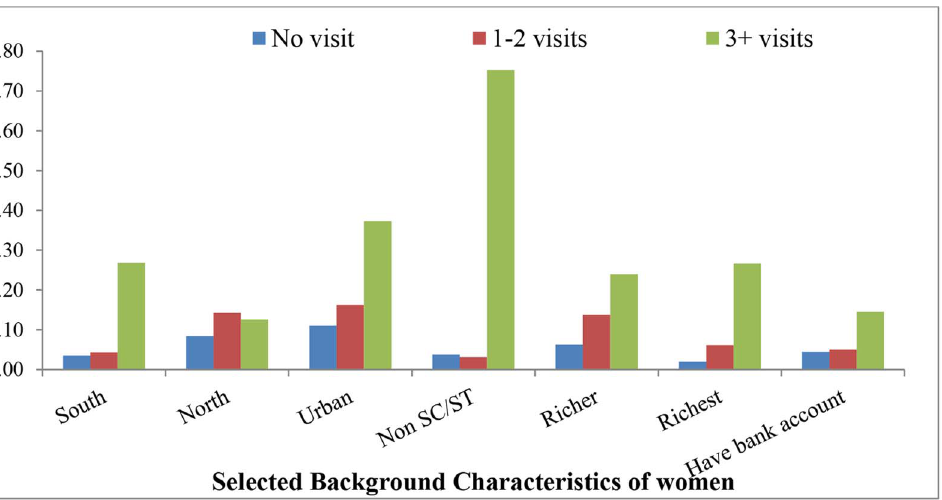
Figure 1. Mean of selected background characteristics of mother who did not visited health center for ANC, who make 1–2 ANC visits and who make more than two ANC visits.